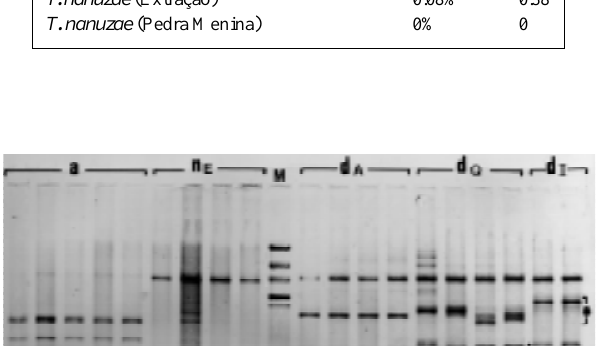
Table III - Nucleotide diversity (p) and haplotype diversity (h) estimated for the Tropidurus populations sampled. Population p h T. divaricatus